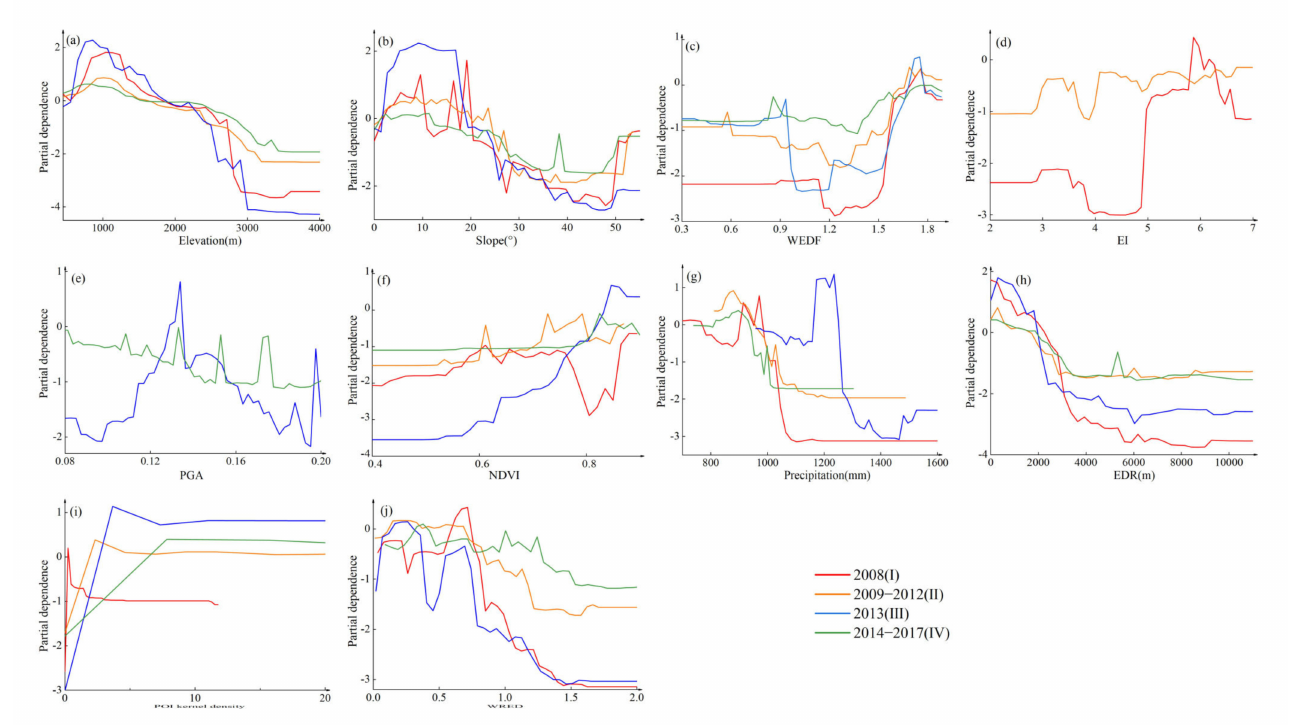
Figure 9. Partial dependence plot in continuous factor: ( a ) elevation; ( b ) slope; ( c ) WEDF; ( d ) EI (from 2 to 7 is intensity VII to intensity XI); ( e ) PGA; ( f ) NDVI; ( g ) precipitation; ( h ) EDR; ( i ) POI kernel density; and ( j ) WEDR.